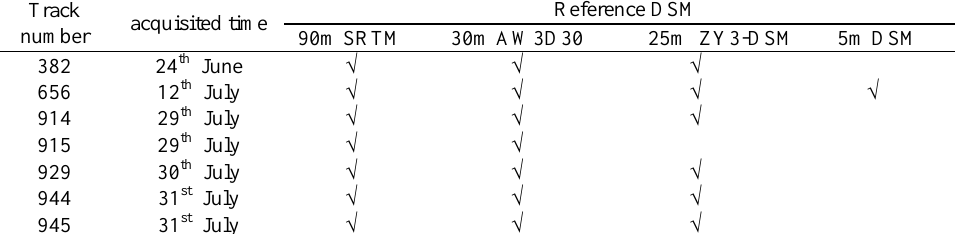
Table 3. The terrain matching experimental data of ZY3-02 satellite